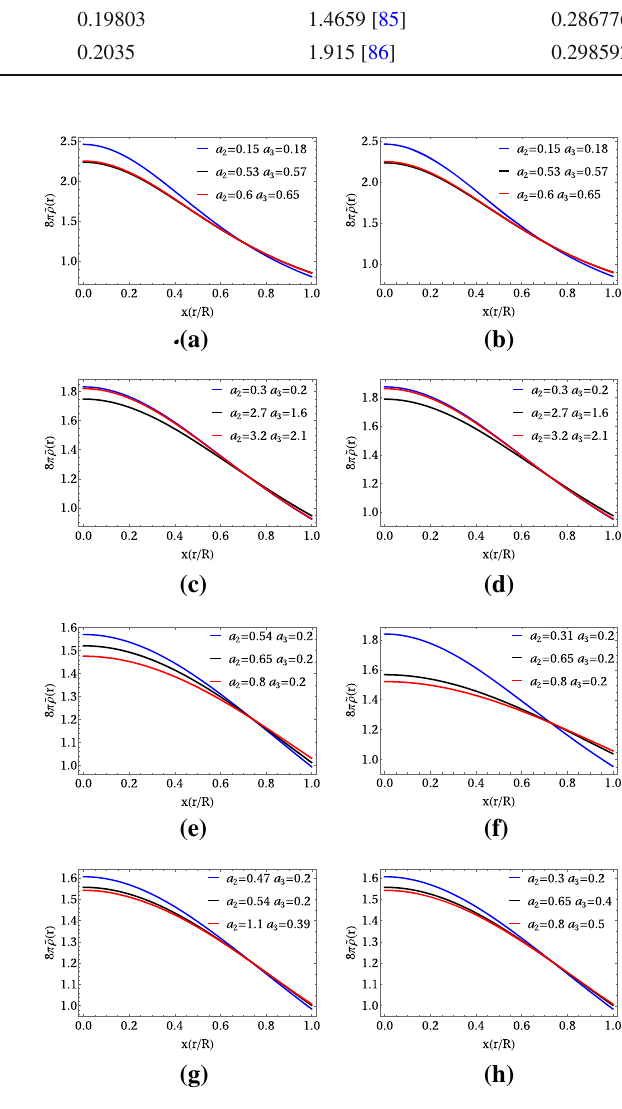
Fig. 3 ρ asafunctionof r forModel1:( a )u=0.19803, ( b )u=0.2035, Model 2: ( c ) u = 0.19803, ( d ) u = 0.2035, Model 3: ( e ) u = 0.19803, ( f ) u = 0.2035, Model 4: ( g ) u = 0.19803, ( h ) u =